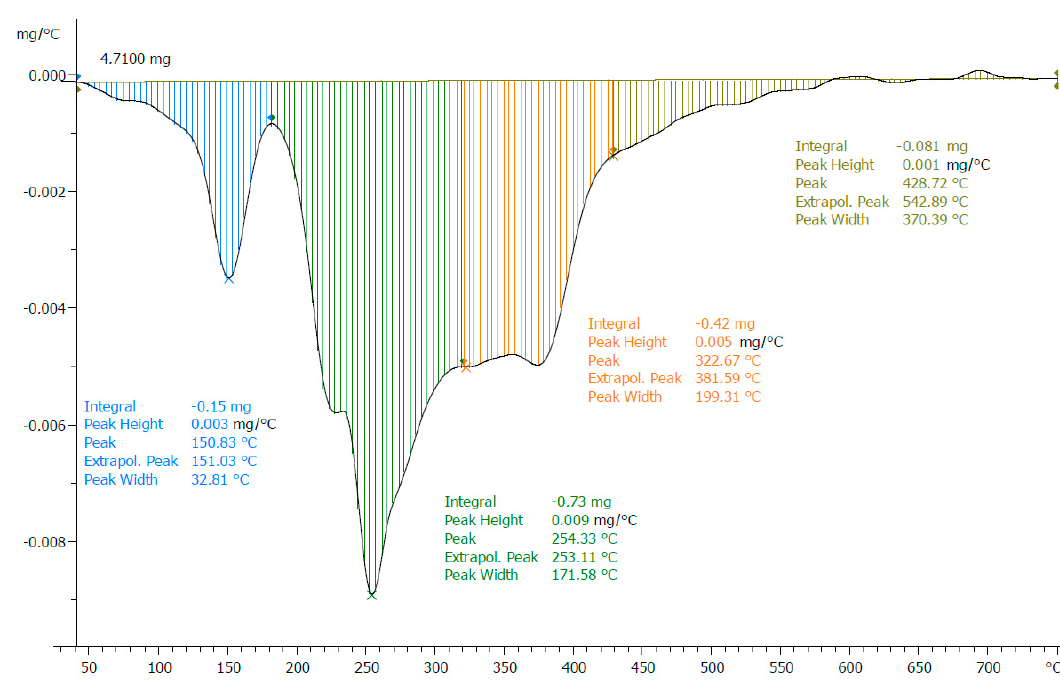
Figure A4. AuNP-maleimide 2a with mass loss of 29.32%. Furan-PG (blue) is responsible for 3.18% mass loss. Maleimide- PEG 4 accounts for a mass loss of 5% and 25% weight percent of all ligands.